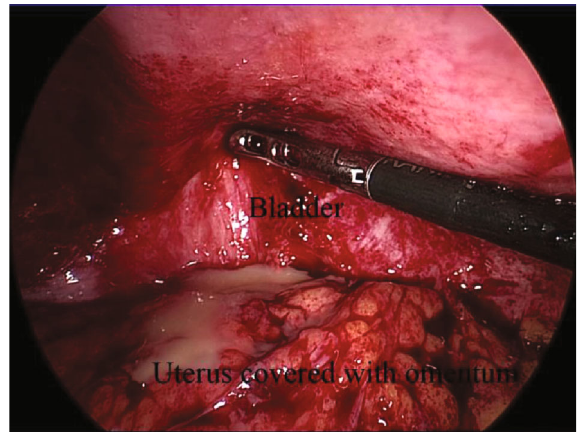
Figure 1: An intraoperative laparoscopic image of the abscess, which was found on the left side of the uterine scar between the posterior bladder wall and the anterior lower uterine body.